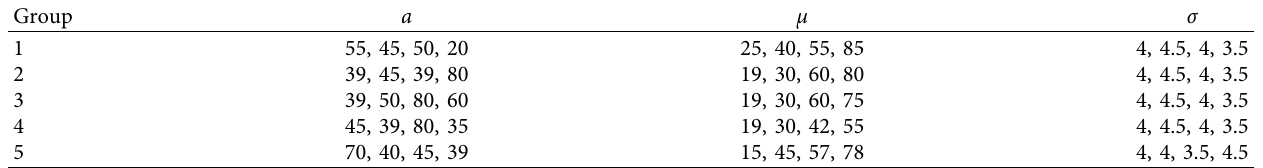
Table 1: Five groups of original parameters of Gaussian function components.